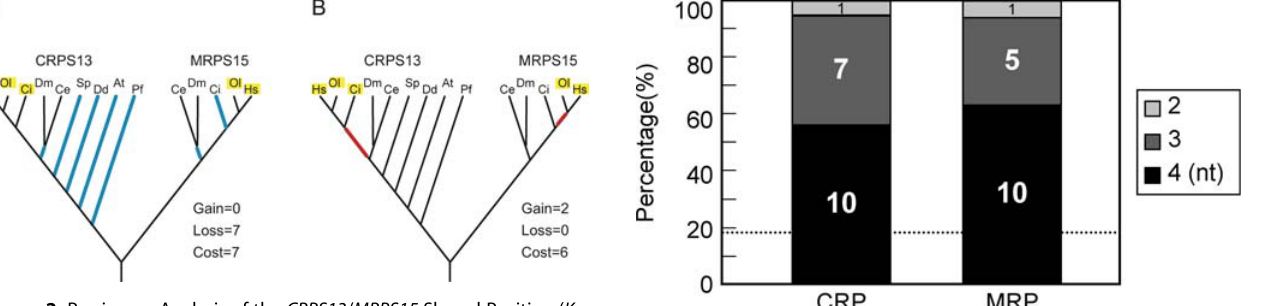
Figure 2. Parsimony Analysis of the CRPS13 / MRPS15 Shared Position ( K ¼ 100) The phylogenetic distribution of the intron position shared between the CRPS13 and MRPS15 genes is shown. Branches that are predicted to have an intron gain or loss are shown in red and blue, respectively. Organisms that currently possess an intron are shown in yellow. The most parsimonious scenario for the case of parallel intron gain was favored because the cost was smaller. (A) The parsimonious scenario of intron evolution for the case of intron position conservation. The ancestral intron was lost on five branches leading to CRPS13 genes (P. falciparum, A. thaliana, Di. discoideum, S. pombe, and the ancestral branch of Ca. elegans and Dr. melanogaster)